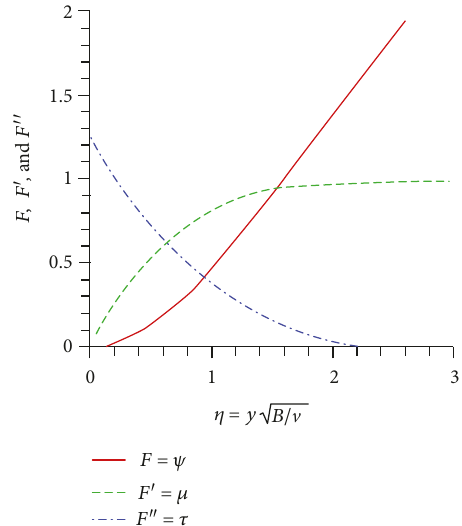
Figure 4: Axisymmetric downburst against ground-velocity